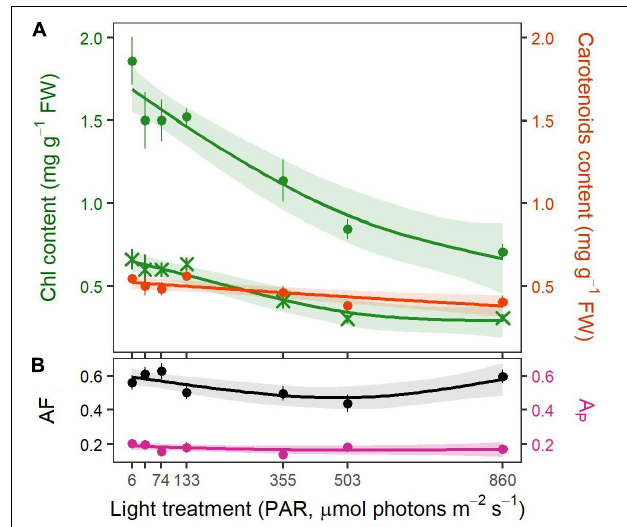
FIGURE 3 | Pigment content and absorptance of eelgrass leaves for each light treatment at the end of the experiment. (A) Chl a (green circles), chl b (green x), and total carotenoids (orange) contents (mg pigment g − 1 FW). (B) Total absorption factor (AF total , black) and photosynthetic absorption factor (AF photo , purple). Dotted values are mean ± SE ( n = 8–9 shoots). Lines represent the fitted values from HGAM models with a 95% CI.